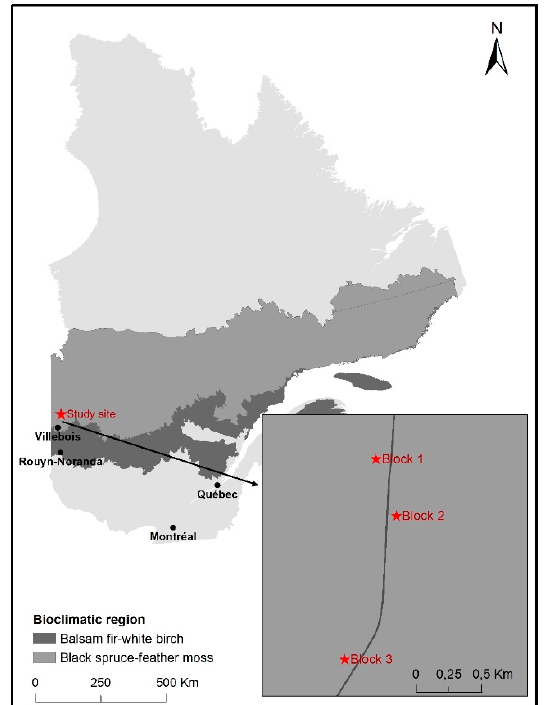
Figure 1. Location of the experimental plots. Each block contains one plot of each 3 treatments (control, girdling and partial harvest).